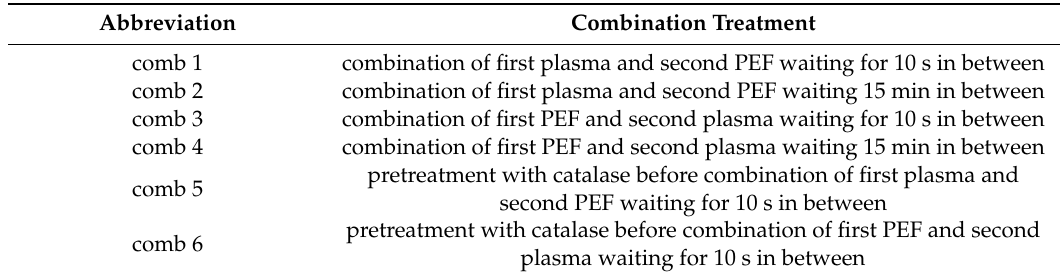
Table 1. Explanation of the abbreviations for the combination (comb) treatment